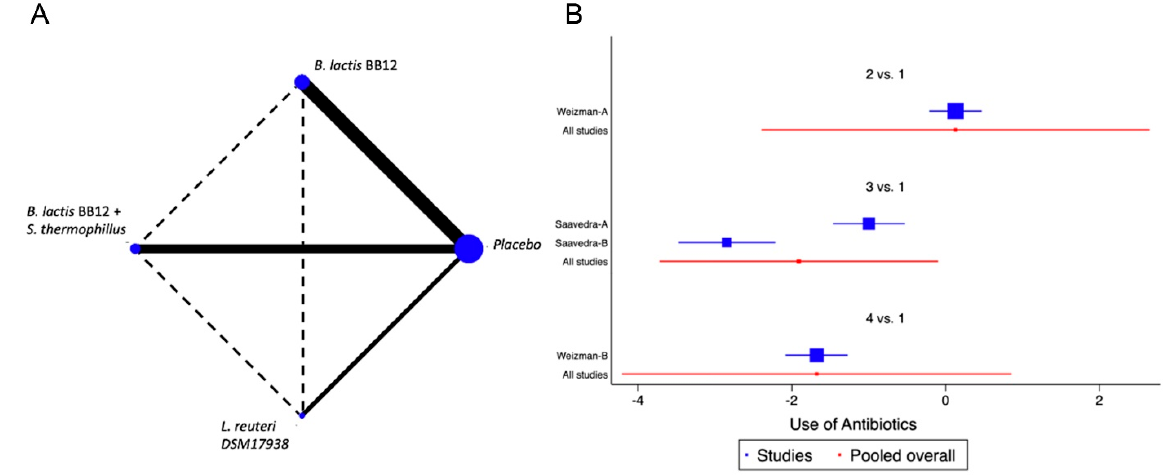
Figure 4. Network Meta-Analysis for probiotics in infant formula and use of antibiotics. ( A ) Network diagram: the area of the blue nodes is based on the total number of patients for each respective interventions, the thickness of continuous lines represents the total number of studies comparing treatments/nodes vs placebo, dashed lines represent comparisons between two active interventions; ( B ) forest plot of multiple treatments.